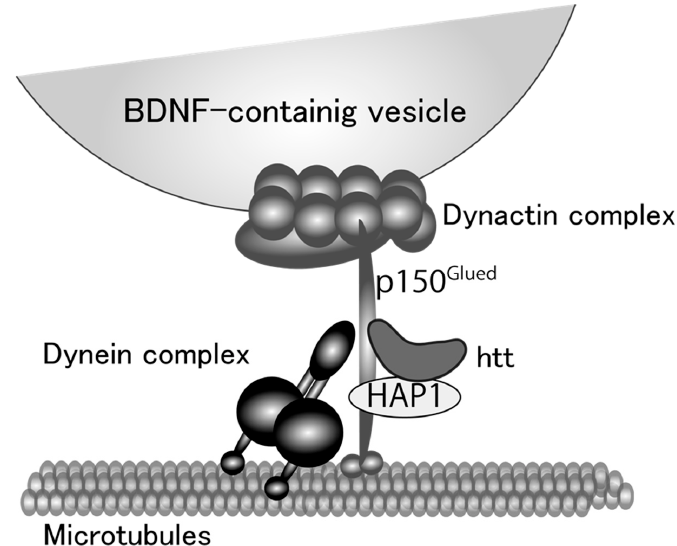
Figure 1. A proposed model for microtubule-dependent vesicular transport of brain-derived neurotrophic factor (BDNF) protein. Huntingtin (htt) and htt-associated protein 1 (HAP1) stabilize the linkage between dynein and dynactin complex. Dynein functions as a motor protein and dynactin complex attaches BDNF-containing vesicles to the motor protein complex with p150 Glued protein.